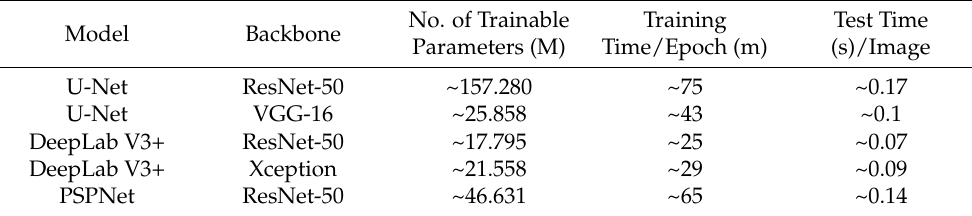
Table 2. Training and testing details for each